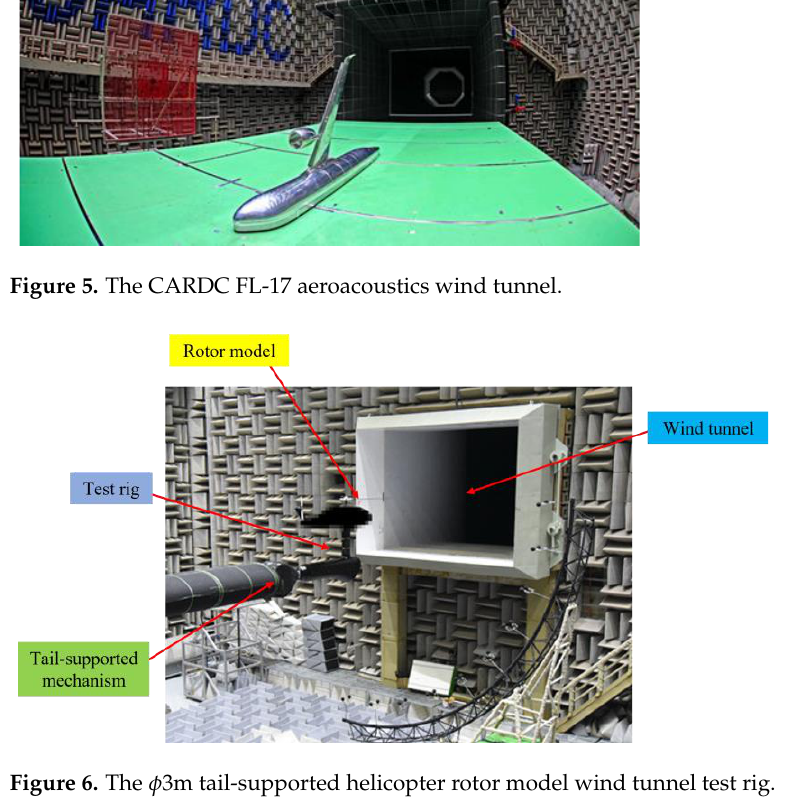
Figure 5. The CARDC FL-17 aeroacoustics wind tunnel.